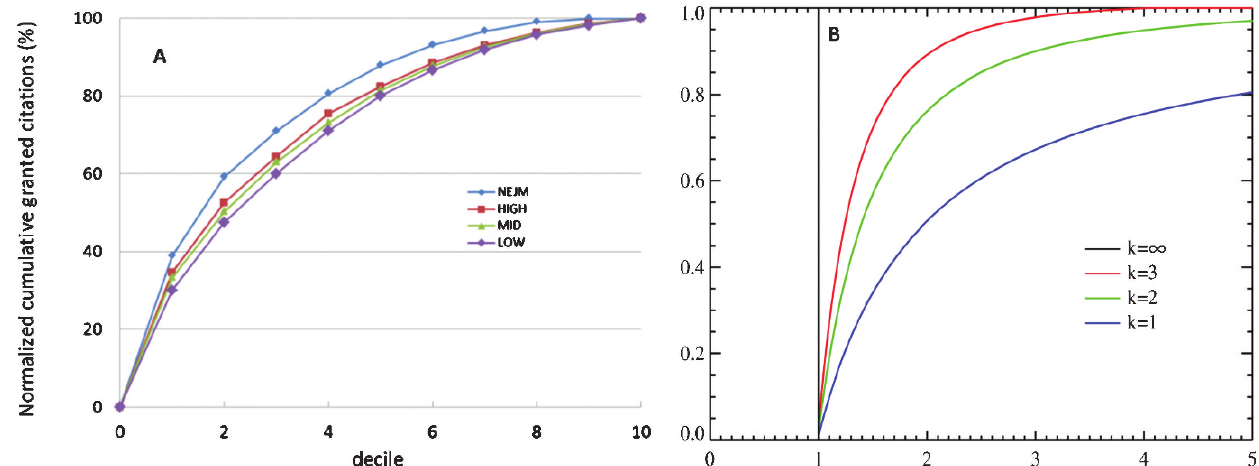
Figure 3 - (A) Normalized cumulative frequency distribution of granted citations to articles in the three major clusters (HIGH, MID and LOW), and for the New England Journal Medicine (NEJM). The ‘‘New England Journal of Medicine’’ exhibits significantly higher values (p , 0.01) for deciles 10 to 50. (B) Pareto cumulative distribution functions for various ‘‘k’’.